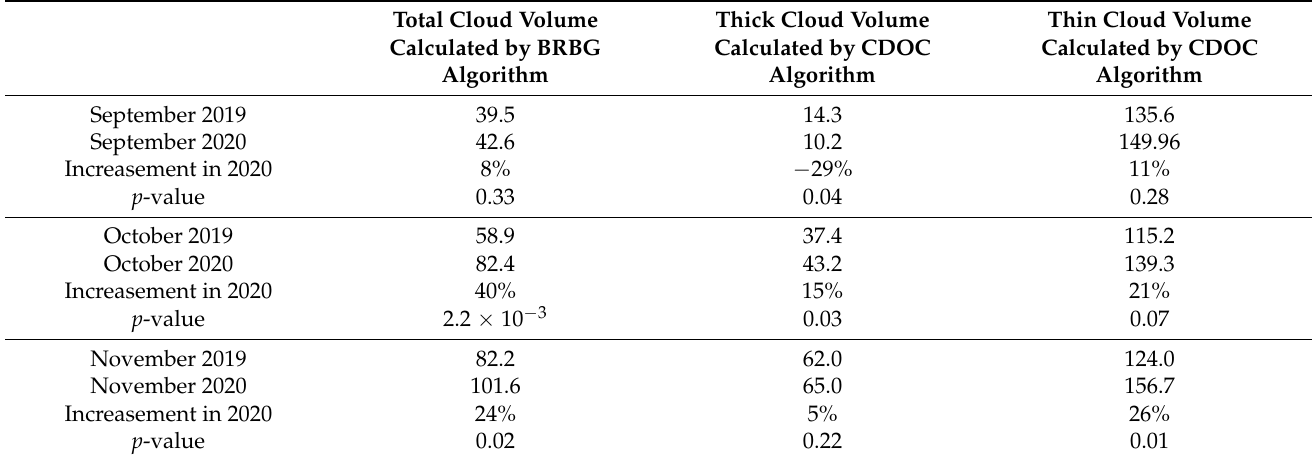
Table 13. Comparison of the daily average cloud amount in the same period in different years. Total Cloud Volume Thick Cloud Volume Calculated by BRBG Calculated by Algorithm